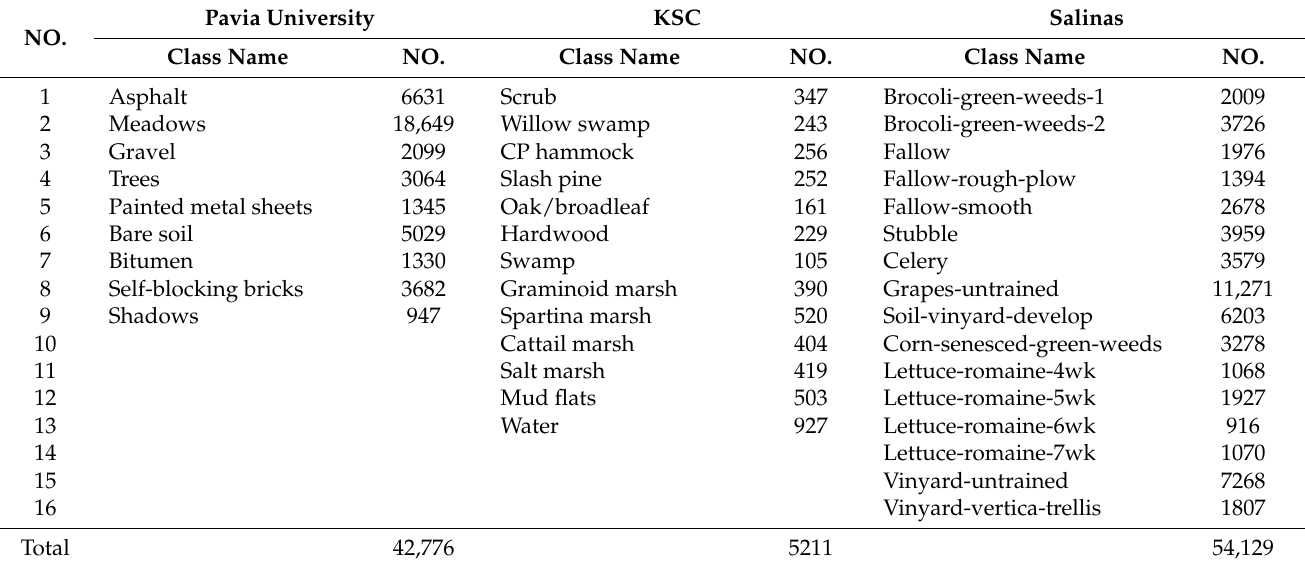
Table 2. Description of hyperspectral remote sensing